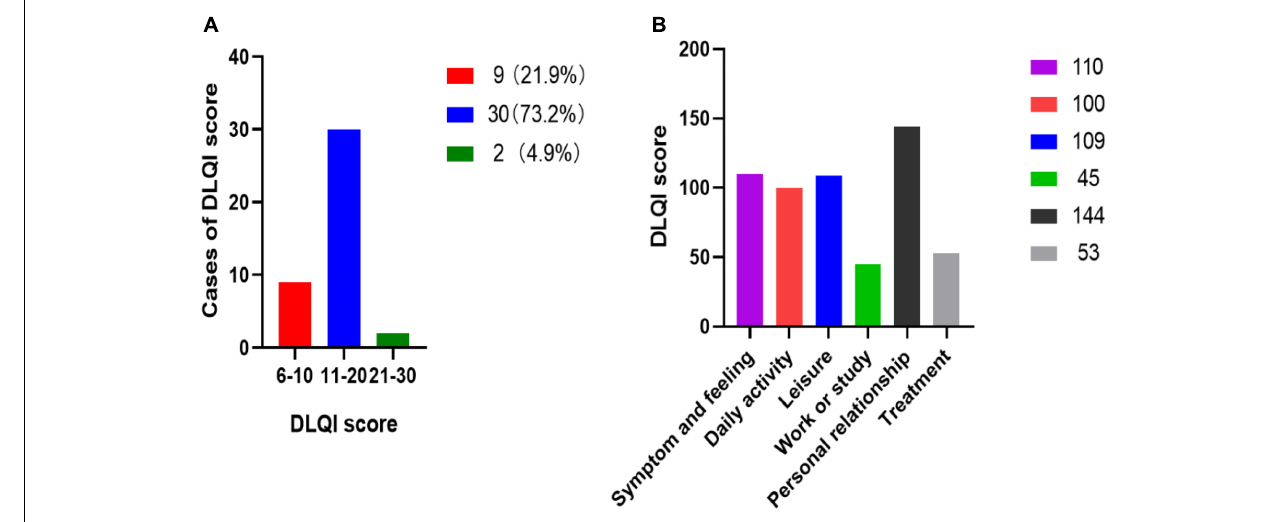
FIGURE 1 | Distribution of DLQI score and six affected dimensions of QoL. (A) The distribution of amputees DLQI score. (B) DLQI score of six affected dimensions of